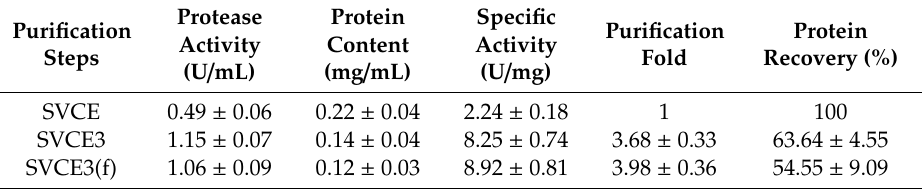
Table 1. Purification efficiency of enzymes from neon flying squid viscera.